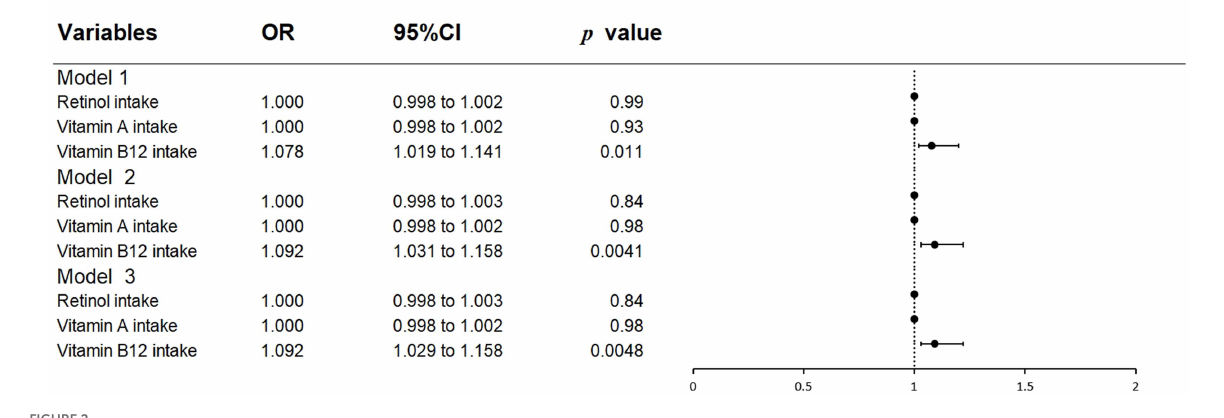
FIGURE 2 Forest plot of logistic regression results.